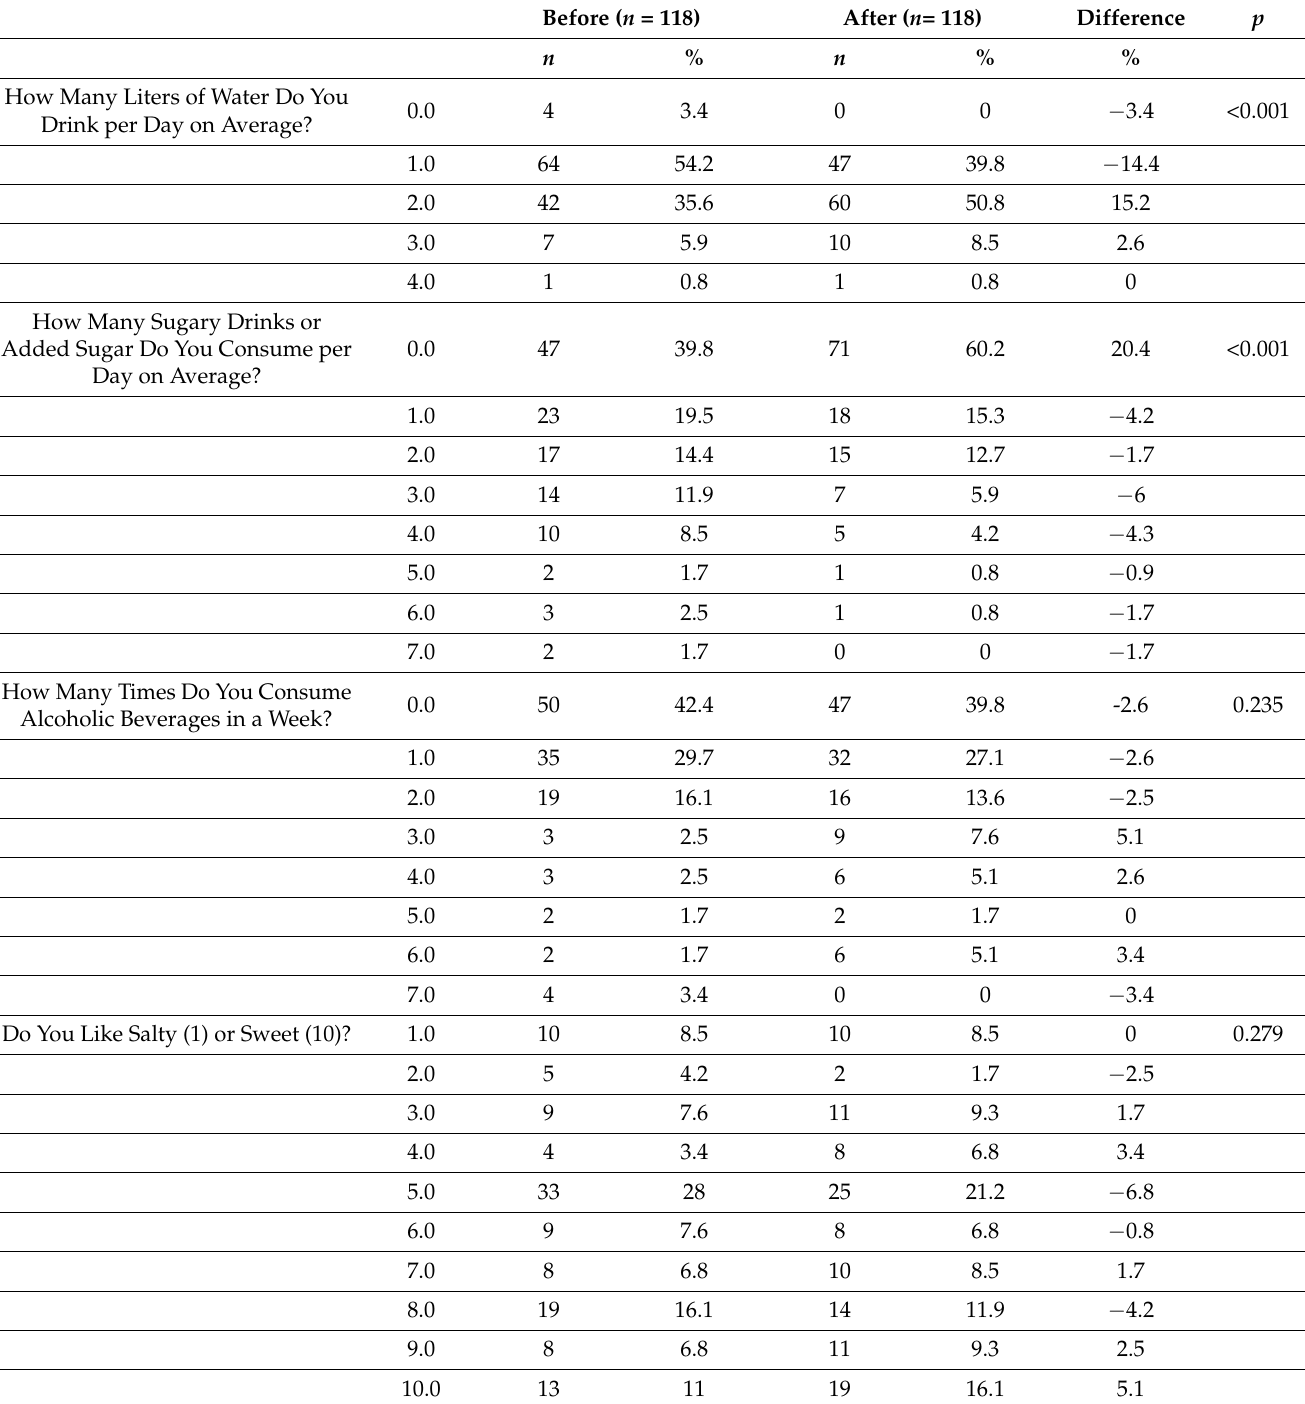
Table 3. Differences in drinking habits before and after